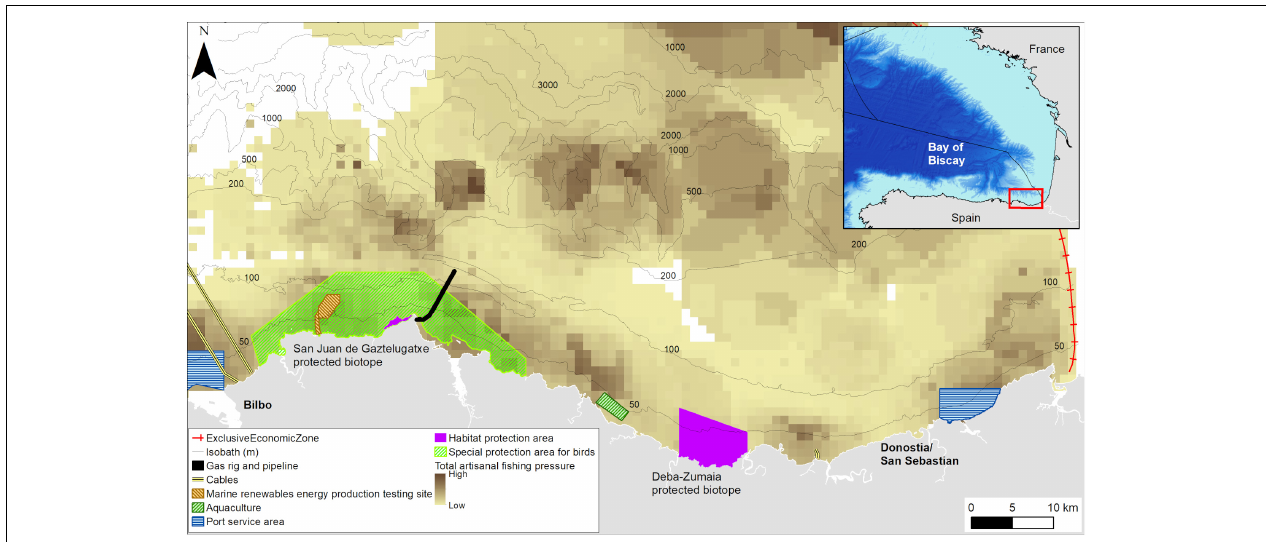
FIGURE 1 | Geographical location of the Basque Country within the Bay of Biscay in the northeastern Atlantic Ocean. Spatial distribution of the main marine uses is shown (i.e., subsoil gas storage rig and pipeline, marine renewable energy production testing site, longline aquaculture production site, port service area for vessel waiting zone, and in background, the spatial distribution of total fishing pressure of artisanal fishery). Protected areas are divided into special protection area for birds and areas declared for benthic habitats